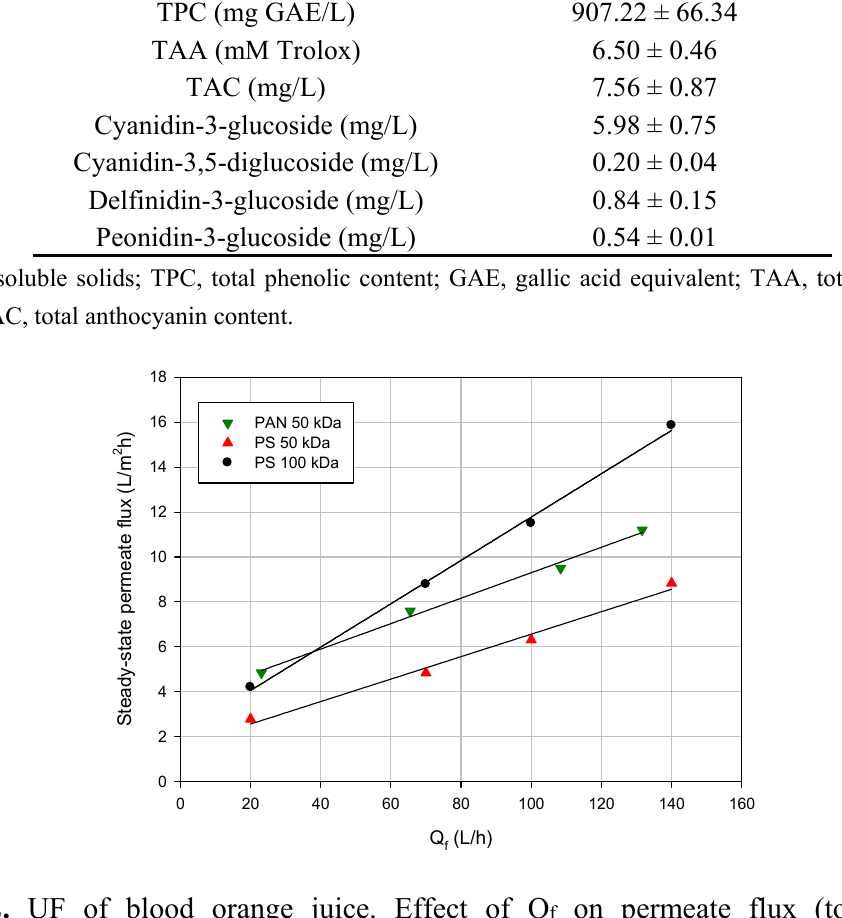
Figure 2. UF of blood orange juice. Effect of Q f on permeate flux (total recycle configuration; TMP, 0.6 bar; T, 20